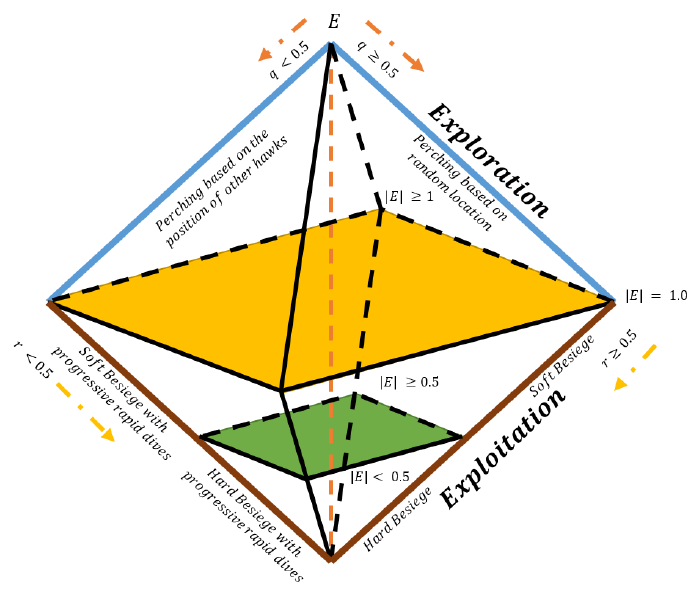
Figure 1. Different phases of HHO.